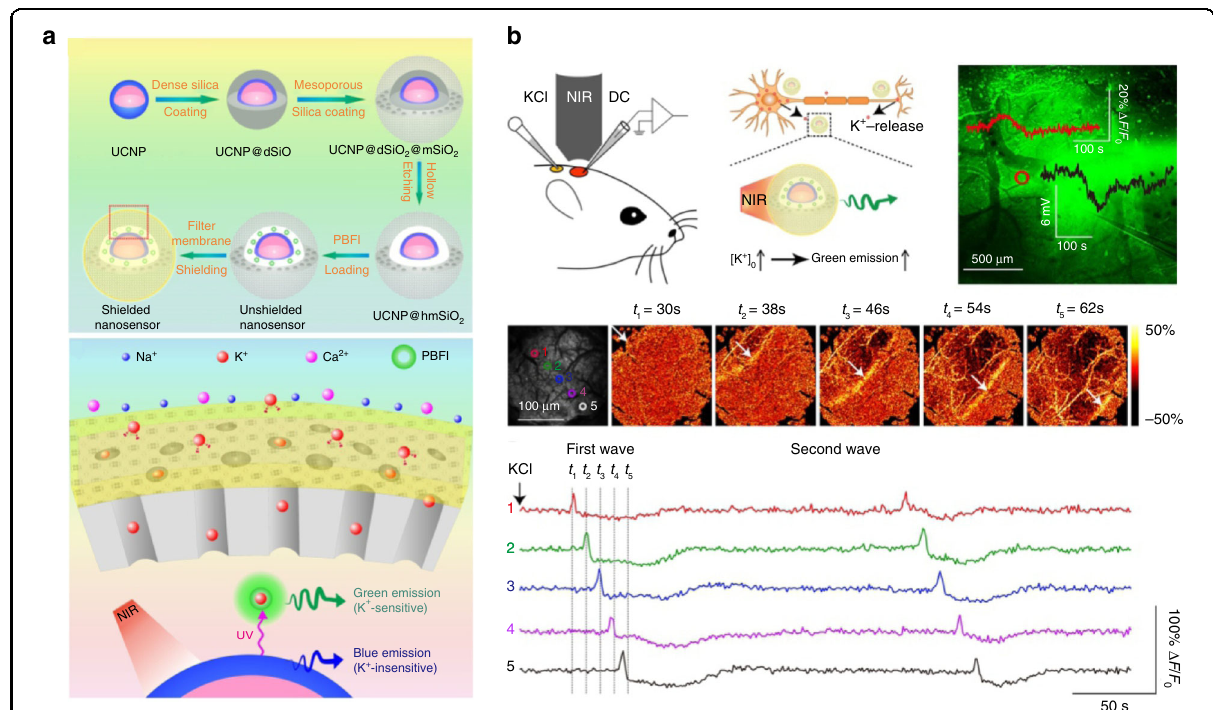
Fig. 9 Rare-earth based materials for imaging the ions changes in brain. a Schematic diagram of K + ions nanoprobe. b Nanoprobe-assisted imaging of extracellular K + waves across the cortical surface in a cortical spreading depression model of mice. Reprinted with permission from ref. 23